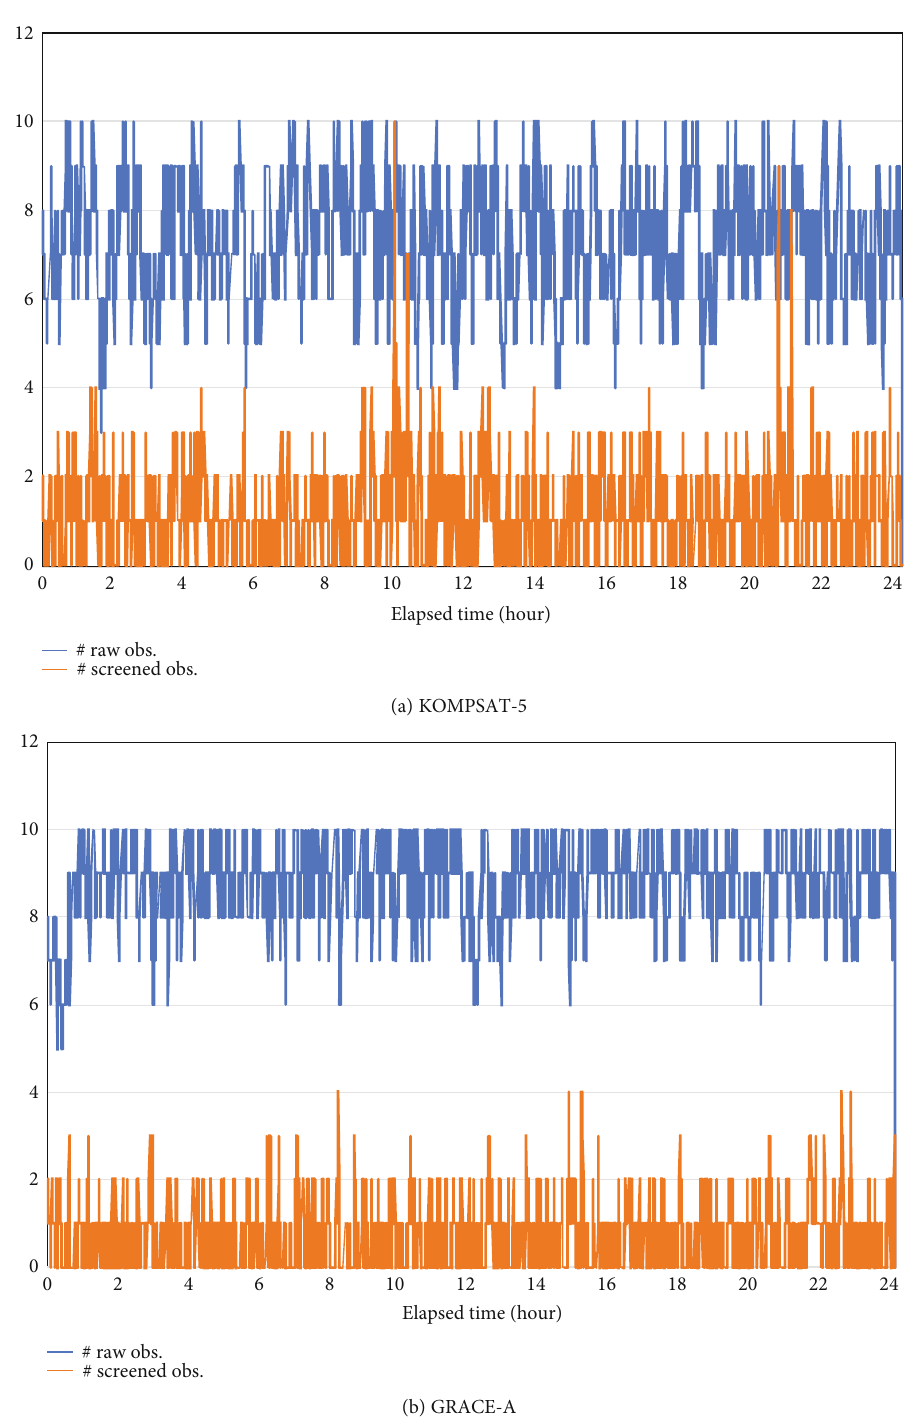
Figure 8: The numbers of raw and screened observations for KOMPSAT-5 and GRACE-A on 14 July